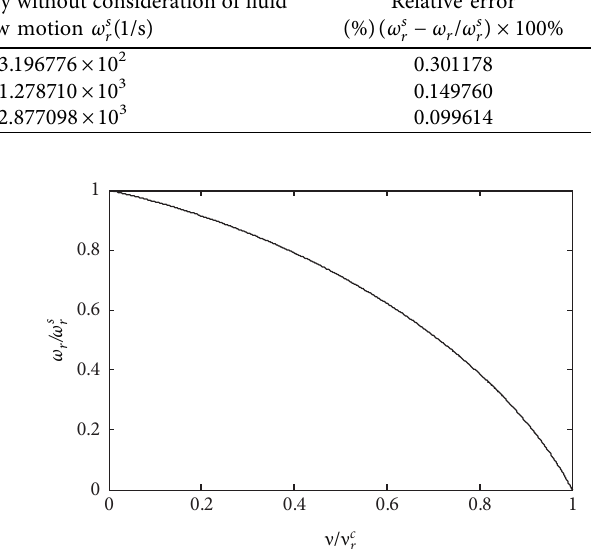
Figure 2: The change curve of natural frequency ratio with liquid velocity ratio of the pipe.